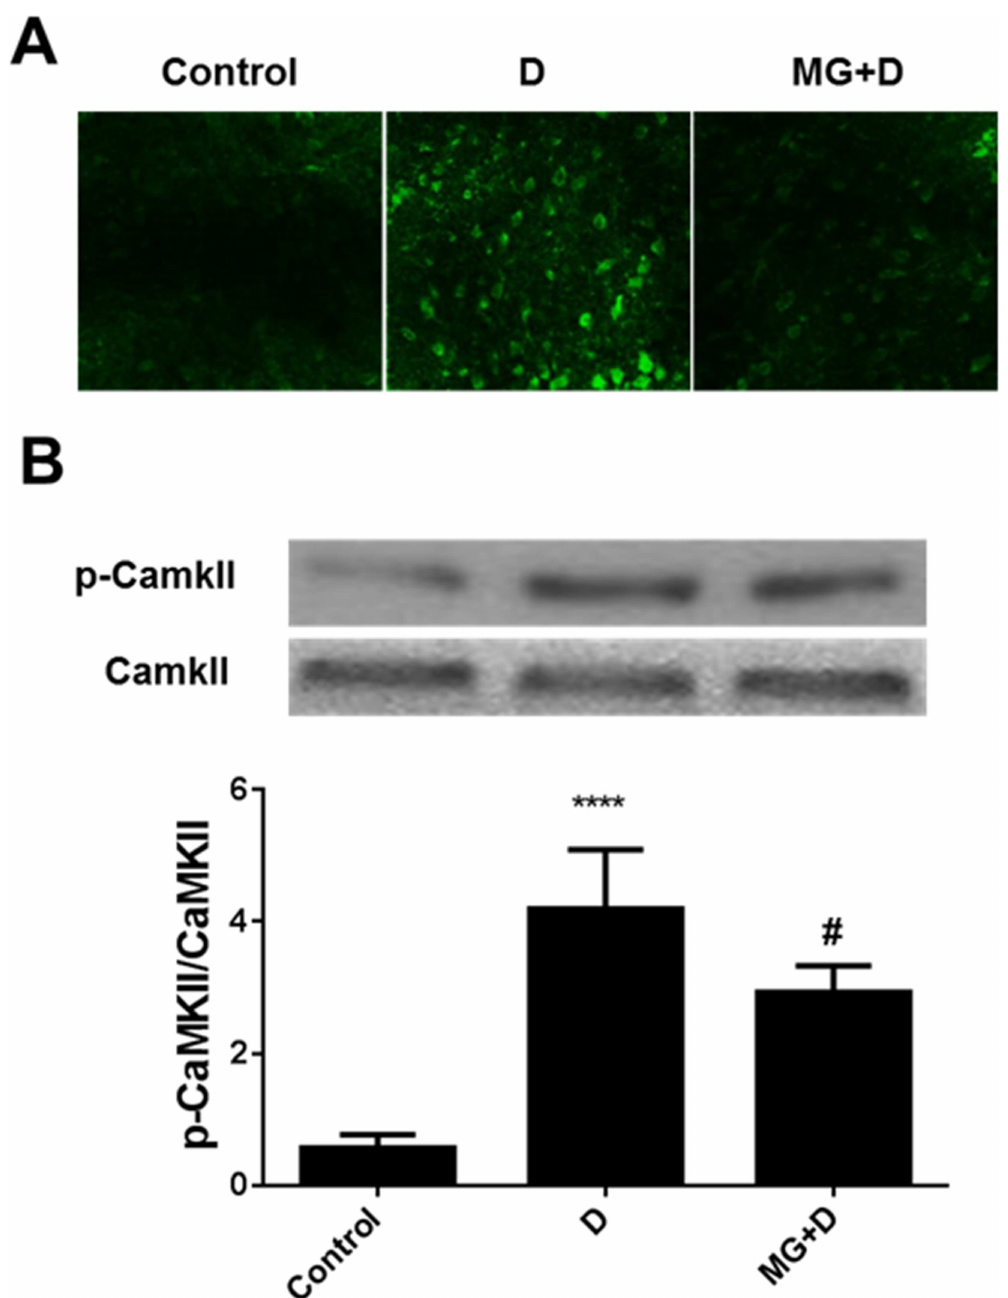
Fig 4. Intracellular calcium level and CaMKII phosphorylation was involved in the protective effect of GB in DOX induced cardiotoxicity. ( A )Intracellular calciumlevel was determined by Fura-2/AM probe. Increased intracellular calciumlevel was found after DOX treatment whileGB pretreatment couldsignificantlydecreasethe calciumlevel ( B ).Western blot analysisof CaMKII phosphorylation. IncreasedCaMKII phosphorylation was found after DOX treatment whileGB pretreatment couldsignificantlydecreasethe CaMKII phosphorylation. **** p < 0.0001 whencomparedto control group, #p < 0.0001 when comparedto DOX.